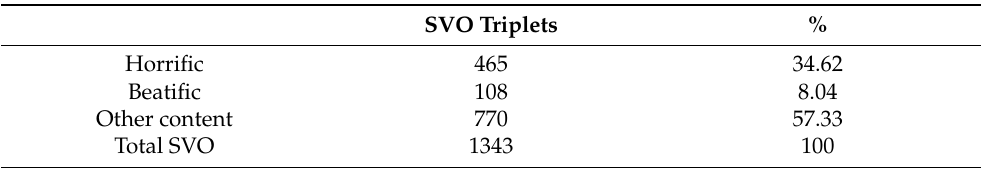
Table 12. Dimensions of fantasy in Bolsonaro’s Twitter